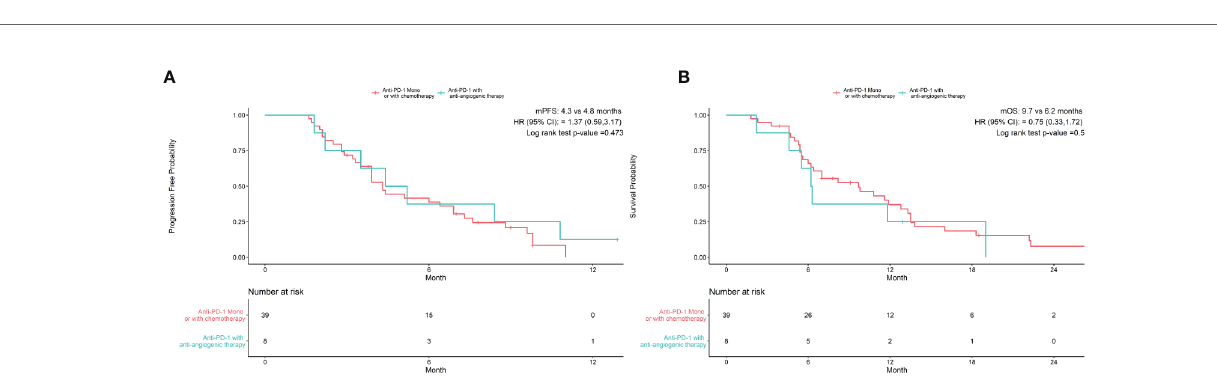
FIGURE 3 | Treatment type hadn ’ t associated with progression-free survival (A) and overall survival (B) in patients with decreased Hb levels.